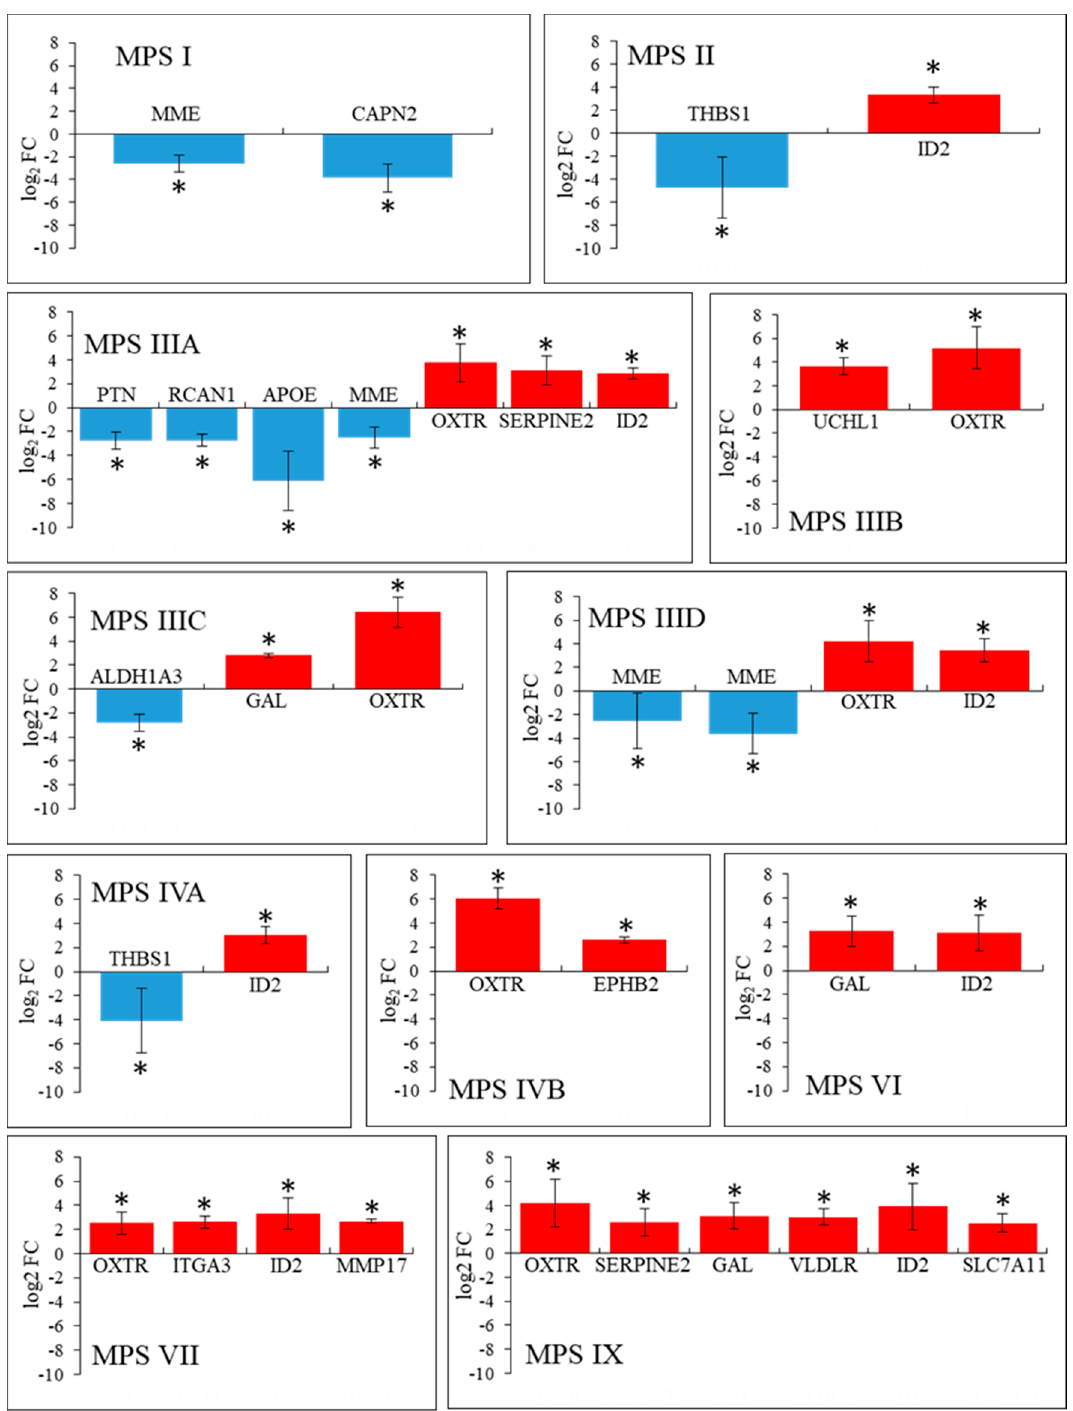
Figure 6. Genes which expression is particularly significantly changed (log 2 FC > 2.5) in different MPS types/subtypes relative to control cells — quantitative analysis. Changes in levels of particular transcripts are presented for each MPS type relative to control cell line (HDFa). Names of genes are indicated. Down-regulation is marked in blue, and up-regulation in red. Presented values are mean values from 4 experiments with SD shown as error bars. Statistically significant differences relative to control (HDFa) cells are indicated by asterisks.